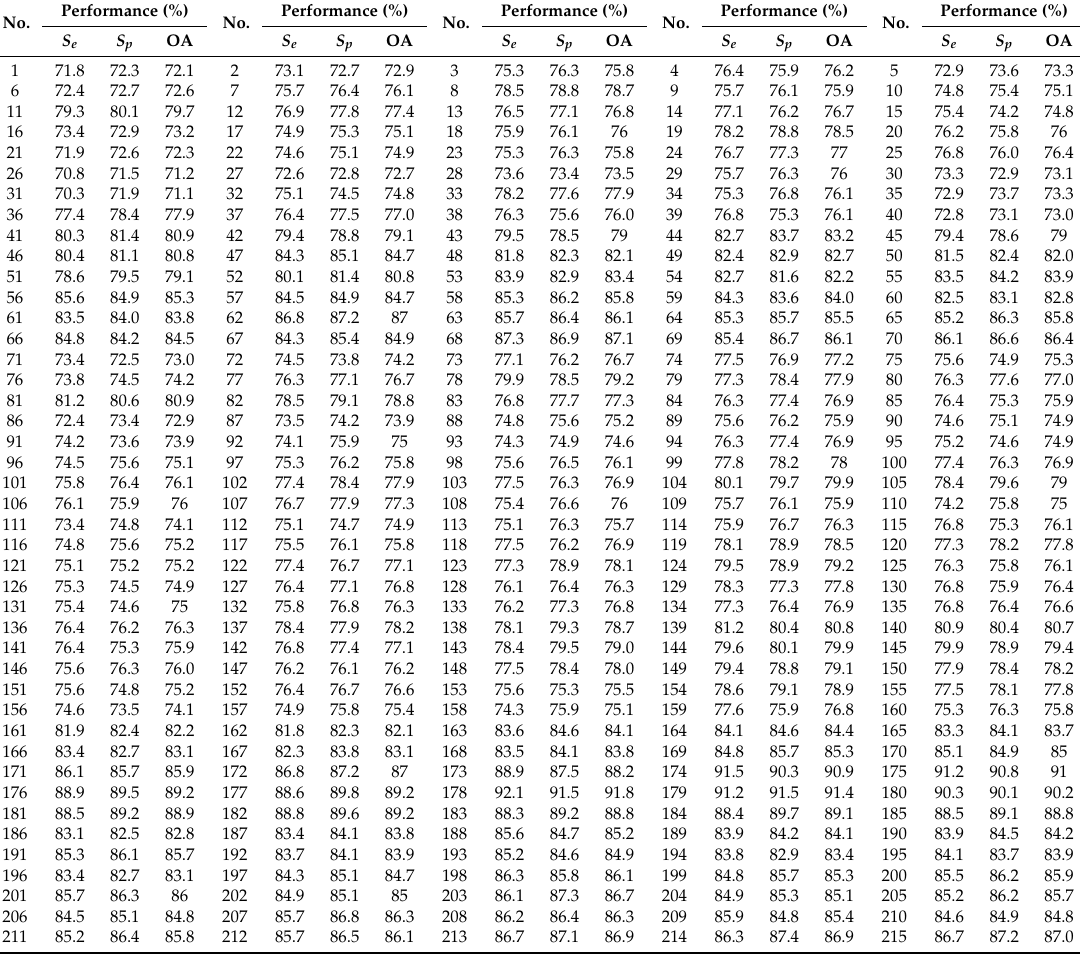
Table A2. Optimal Design of GA-SVM-MKL Classifier in 285 Scenario using Various Kernel and Kernel